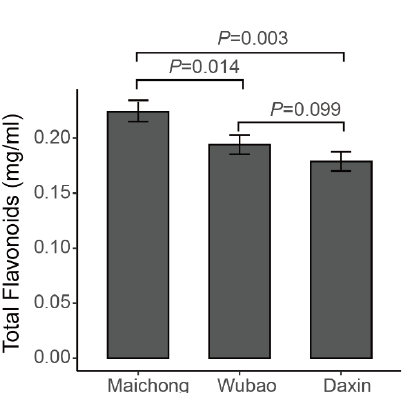
Figure A1. Total flavonoid content of Citrus reticulata ‘Chachi’.